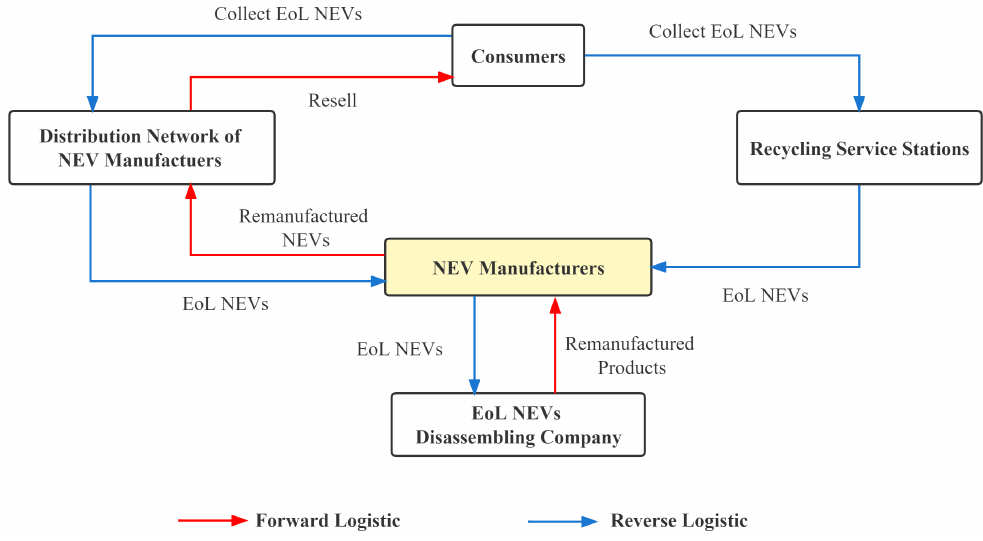
Figure 5. NEV enterprise recycling